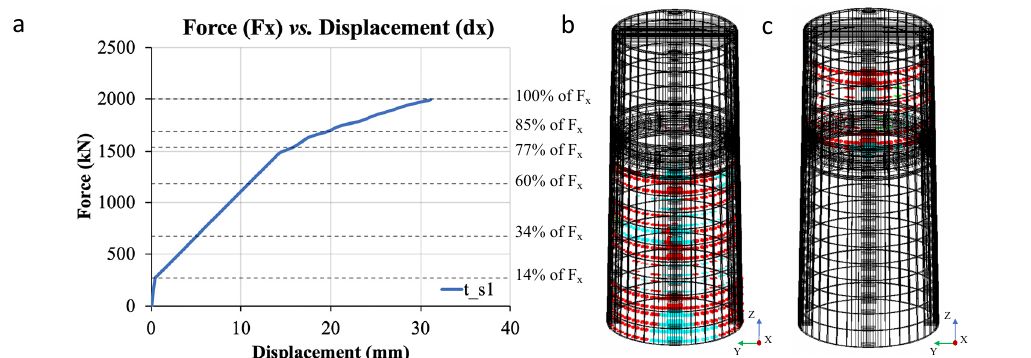
Figure 6. (a) Force vs. Deflection; Crack pattern: (b) bottom ring and (c) top ring, model “t_s1” (crack status: opening in red colour; reopening in cyan colour).